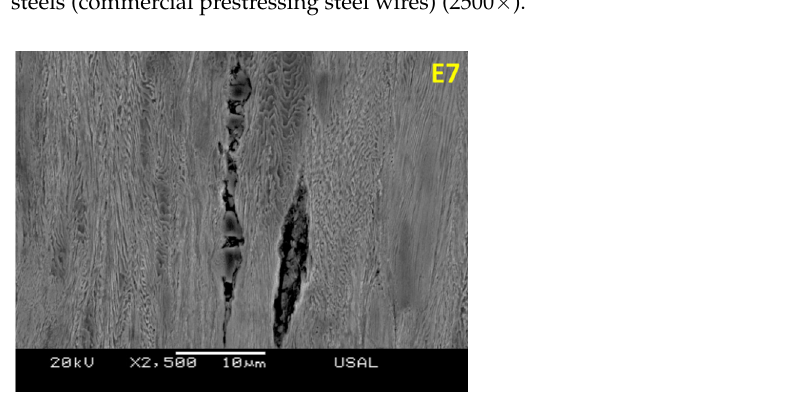
B7 Figure 13. Fracture surfaces in a hot rolled bar ( left ) and a cold drawn wire ( right ). To understand such a disparity regarding fracture surface appearance, some micro- structural features must be taken into account: (i) firstly, the oriented pearlitic micro- structure after cold drawing in the matter of colonies and lamellae [22–25], (ii) secondly, the presence in the drawn steel of many zones with pre-damage (after heavy drawing) and even with micro-cracks aligned in the drawing direction and created in the vicinity